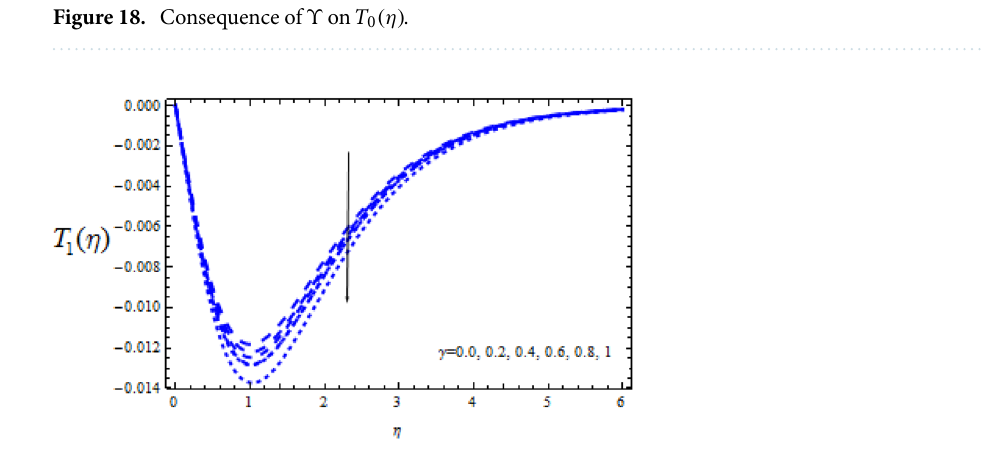
Figure 19. Consequence of ϒ on T 1 (η)